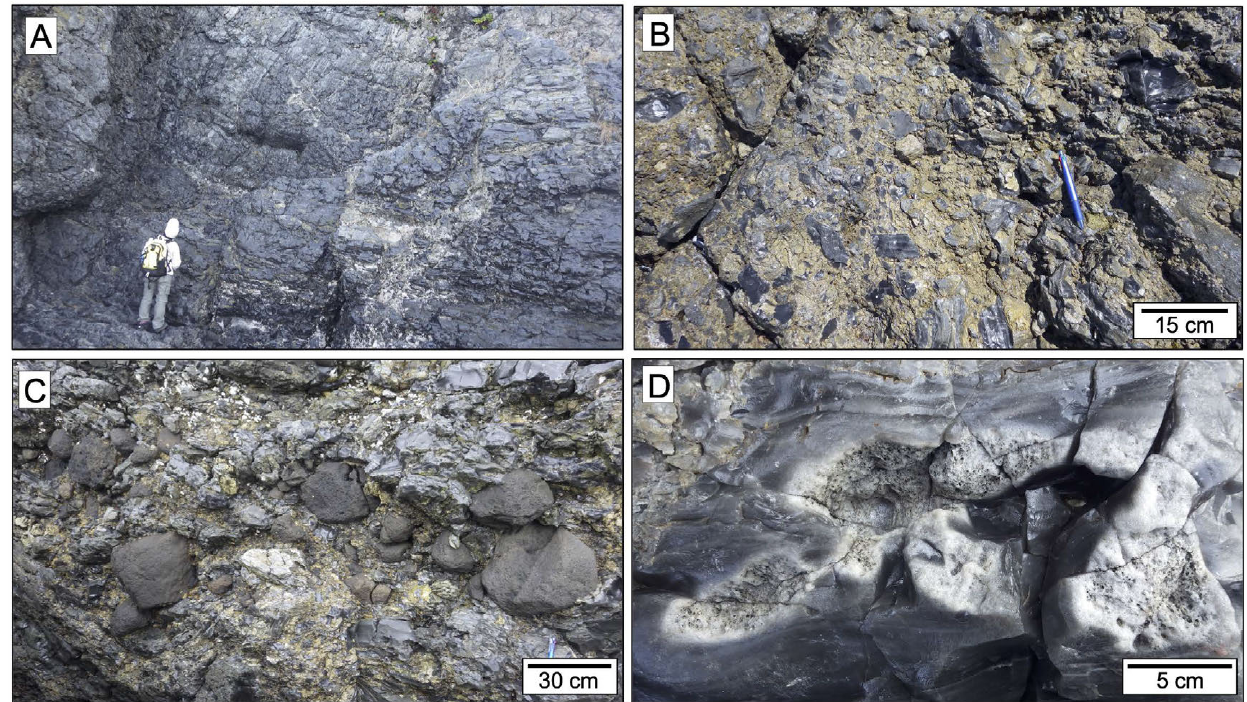
Figure 9: [A] Section showing the massive obsidian of the massive to brecciated obsidian zone. [B] Brecciated obsidian of the massive to brecciated obsidian zone. [C] Concentration of the rounded andesite clasts. [D] Patchy pumiceous structure developed in the massive obsidian.